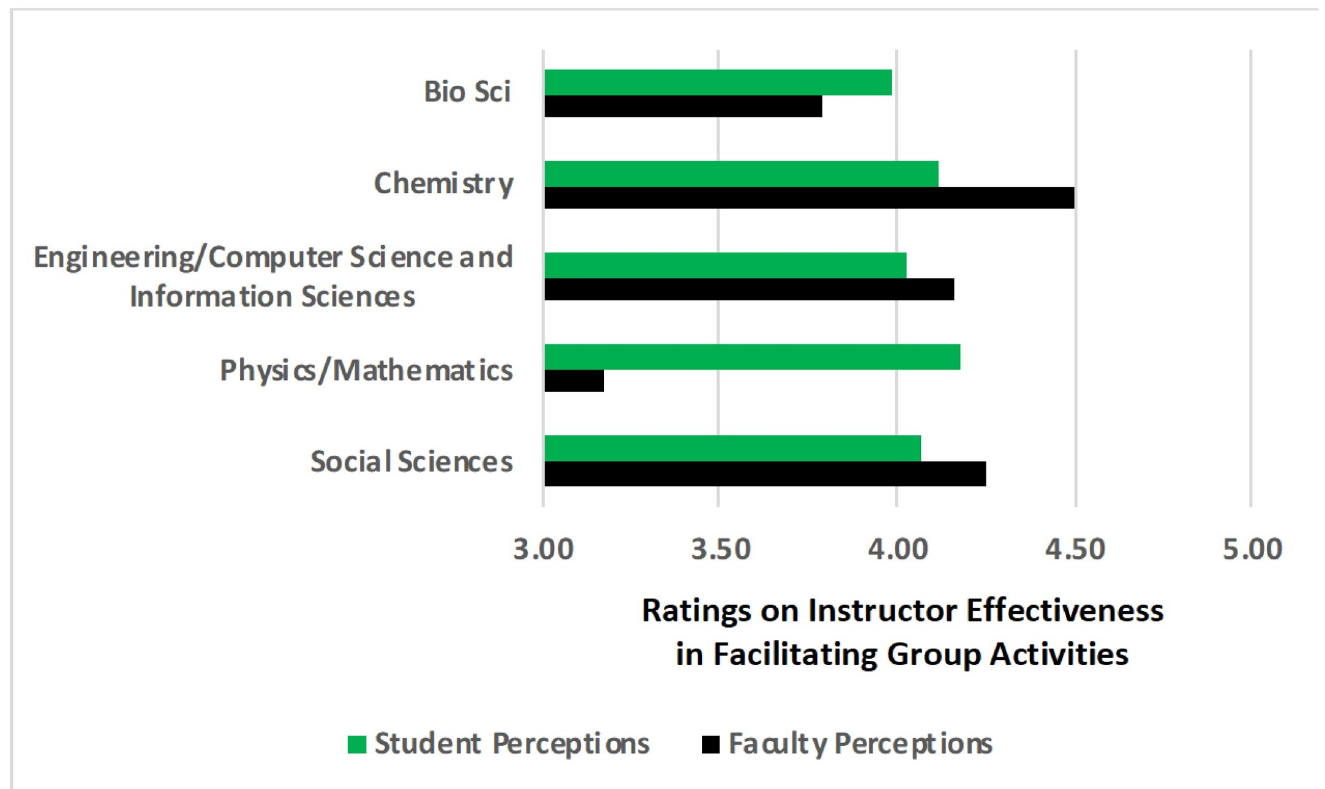
Fig 2. Alignment of faculty and student perceptions across disciplines. Social Science includes public policy/social ecology/psychology.